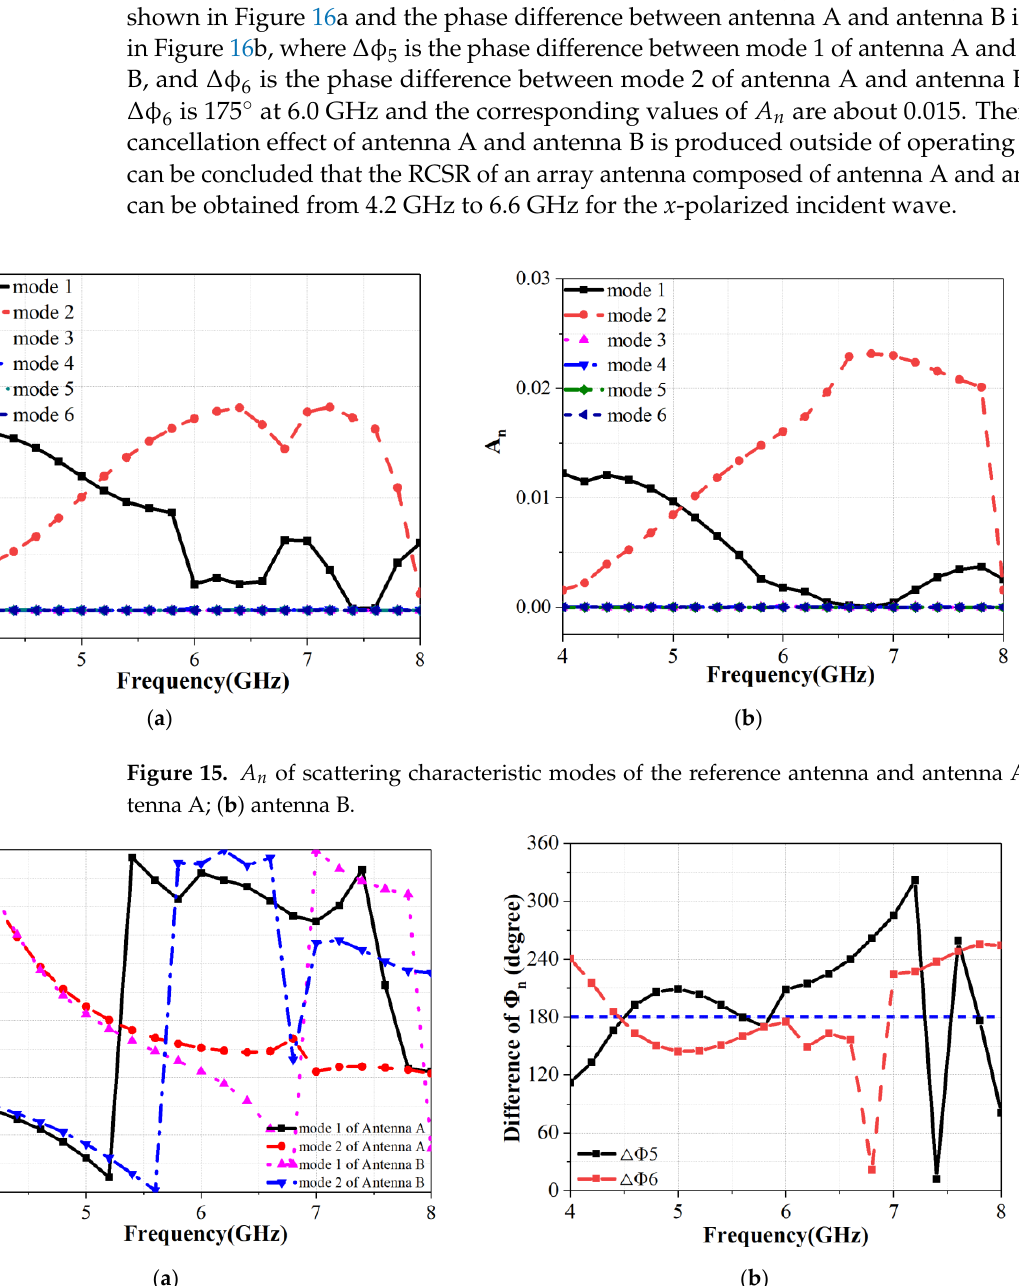
of the dominant 𝑛